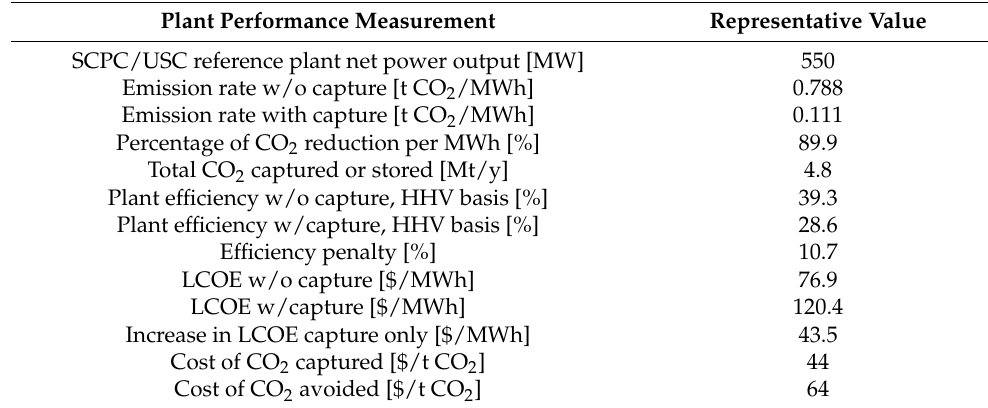
Table 4. Techno-economic analysis for CO 2 separation with membrane technology performed by MTR for post-combustion capture in SCPC coal-fired power plant [22]. Performance and Cost Measurement for New SCPC with Bituminous Coal Integrated with the Membrane Capture System Plant Performance Measurement Representative Value SCPC/USC reference plant net power output